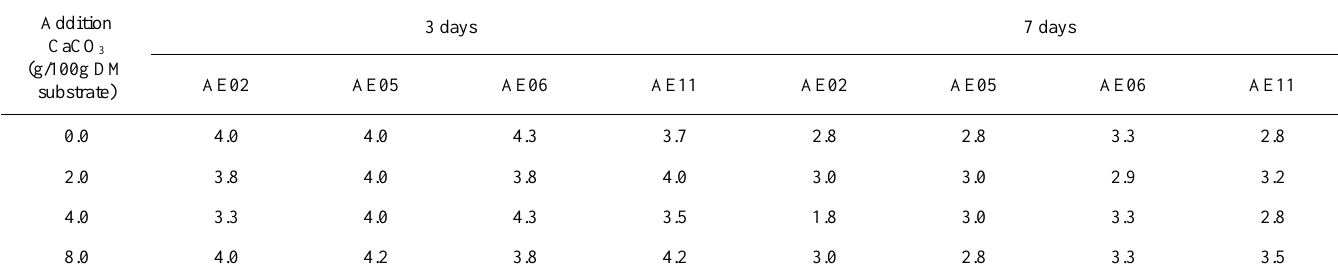
Table 5. Influence of addition of CaCO 3 on quality of fruiting bodies after 3 and 7 days storage in cold room at 2 to 4° C [%]